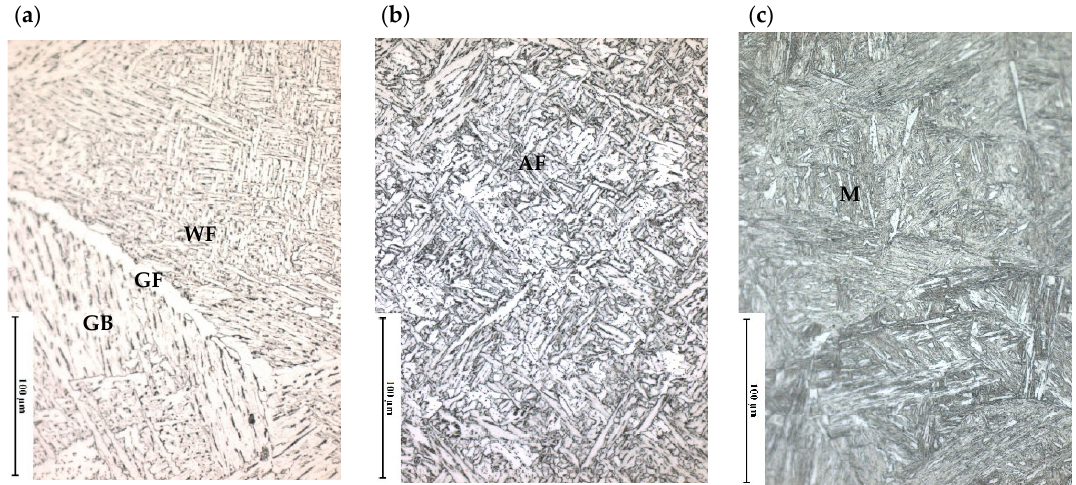
Figure 5. Microstructure of alloys A ( a ), B ( b ) and C ( c ) after applying schedule I.